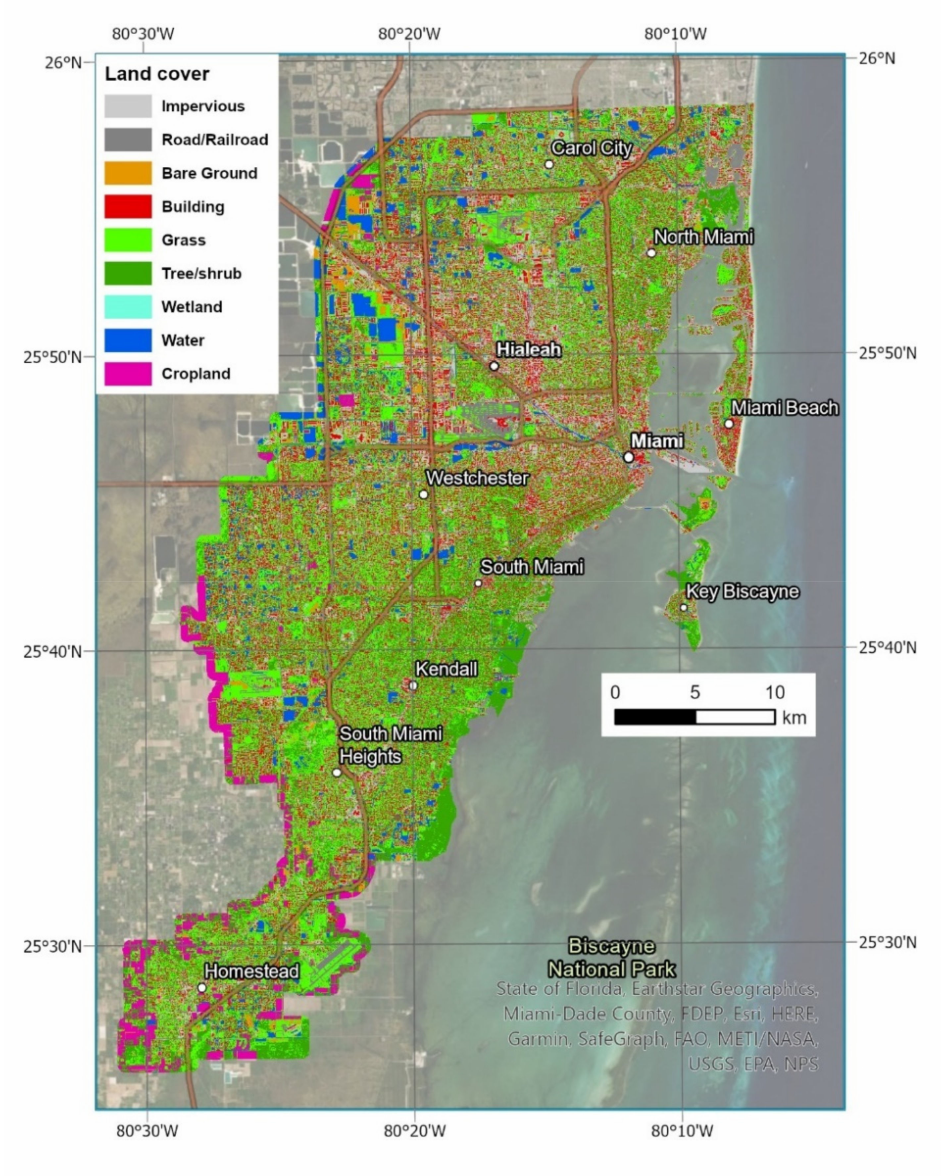
Figure 1. Generated 2019 land cover classification map within the UDB of Miami-Dade County (background map credits: State of Florida, Earthstar Geographics, Miami Dade County, FDEP, Esri, HERE, Garmin, SafeGraph, FAO, METI/NASA, USGS, EPA,